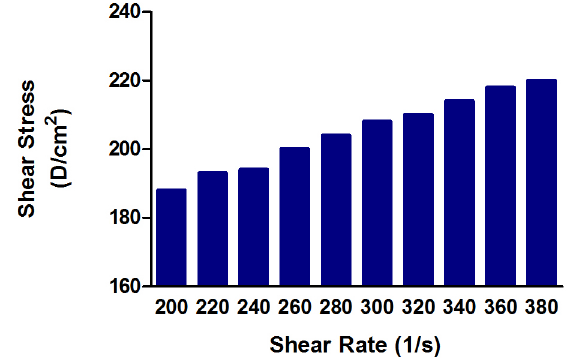
FIGURE 8 - Rheogram of freshly prepared CF emulsion. TABLE VI - Viscosity of emulsions during storage for 2 months Time (months)